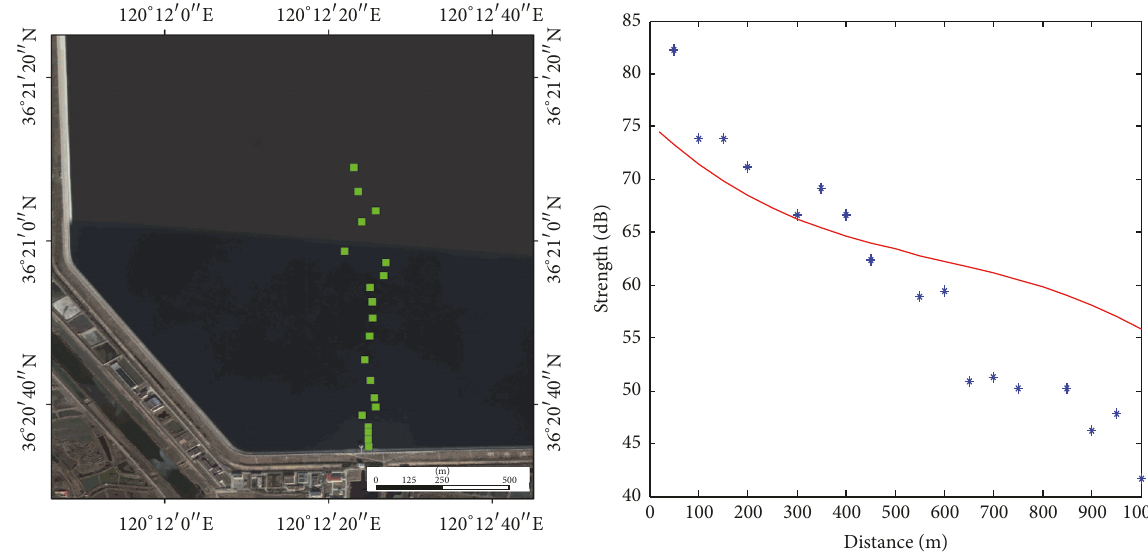
Figure 6: Fixed points strength